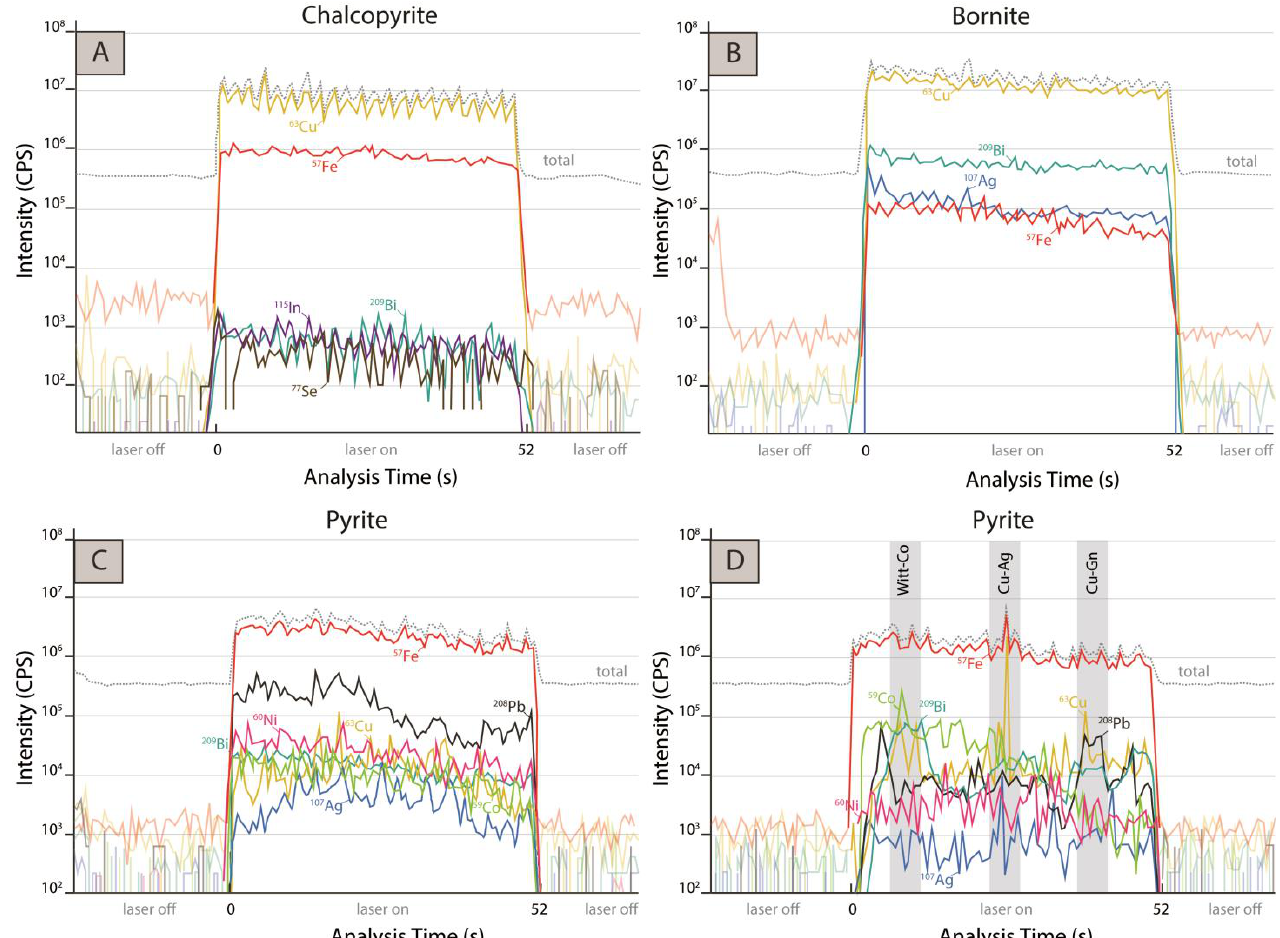
Figure 8. Representative LA-ICP-MS depth-concentration profiles (time vs. intensity) of selected isotopes in sulfides (chalcopyrite, bornite, and pyrite). ( A ) Depth-concentration profile of spot analysis from chalcopyrite, where flat signals are observed. ( B ) Depth-concentration profile of spot analysis from bornite, where flat signals are shown. ( C ) Depth-concentration profile of spot analysis from pyrite, where mostly “flat” signals are identified. ( D ) Depth-concentration profile of spot analysis from pyrite, where the presence of galena, wittichenite (coupled 63 Cu and 209 Bi peaks), Cu, Co, and Ag mineral particles are inferred.